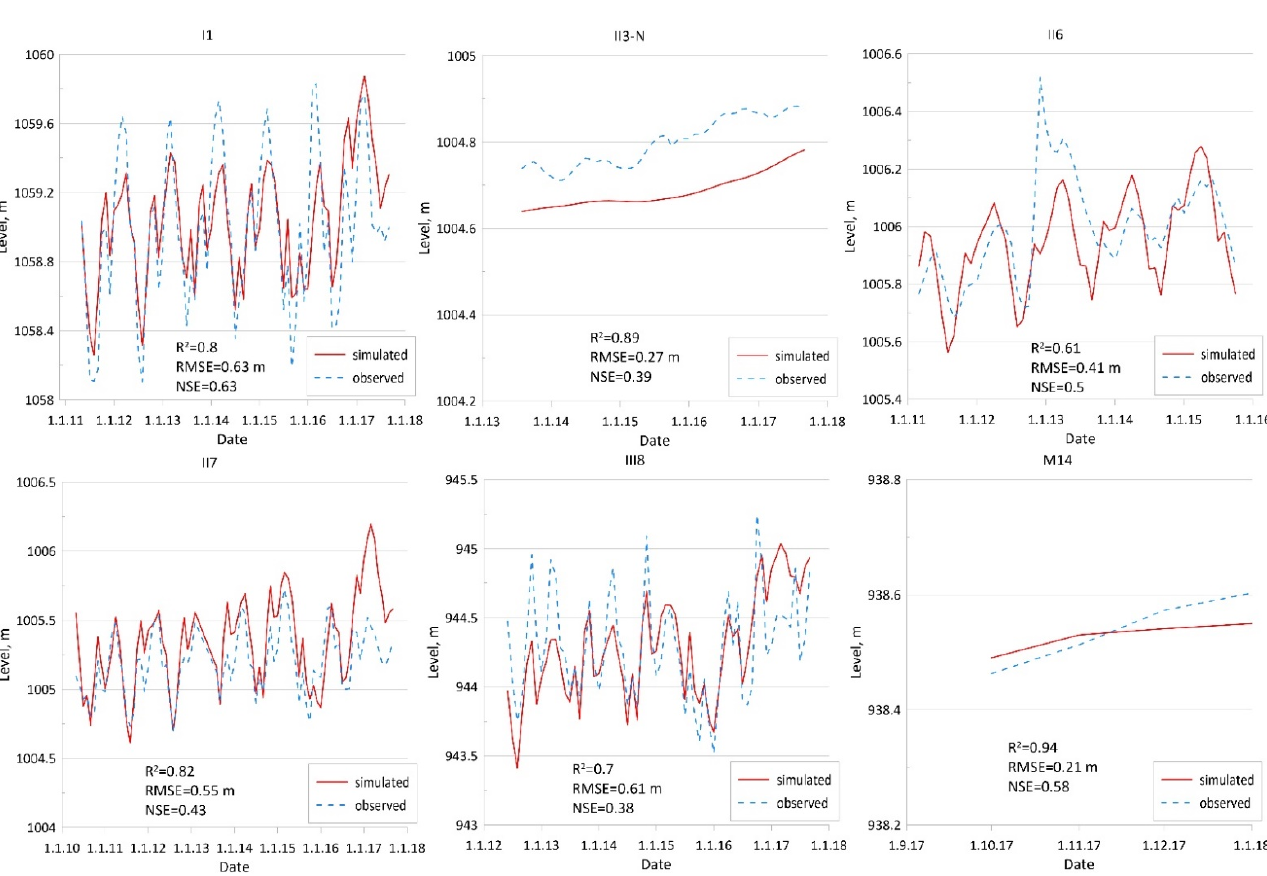
Figure 11. Time series of the simulated and observed groundwater levels over the period 2000–2017. The locations of the observation wells are plotted in Figure 7.